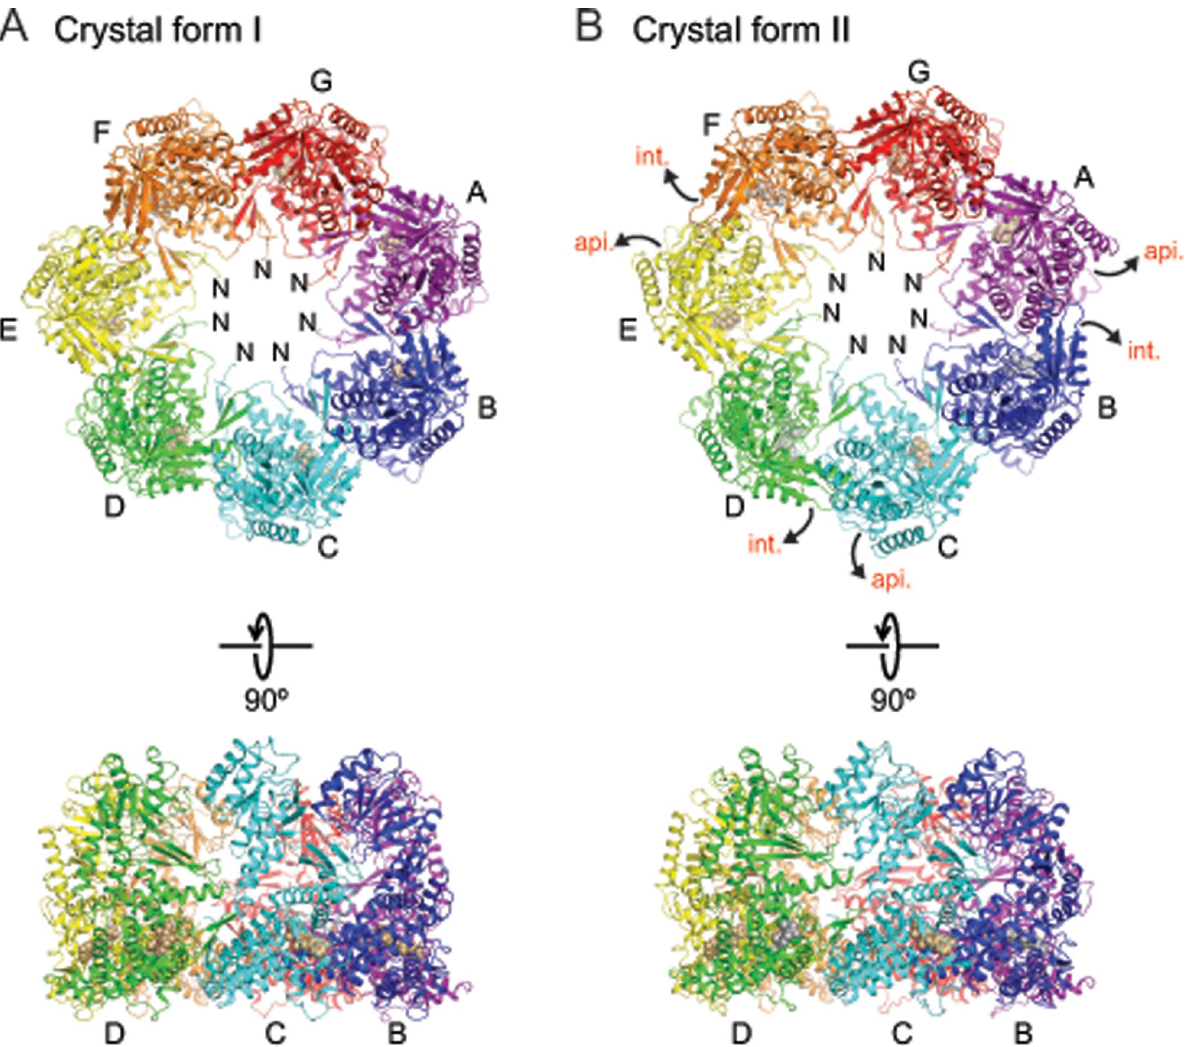
Fig 5. Crystal structures of ɸ EL. (A) Ribbon representation of the ɸ EL complex in crystal form I. Perpendicular views of the ɸ EL complex are shown. The subunits are shown in rainbow colors. Bound ATP and Mg 2+ is colored beige and shown in space-filling mode. Subunit chain identifiers and N-termini are indicated. (B) Structure of the ɸ EL complex in crystal form II, using the same representation style. Bound ADP is colored silver and shown in space-filling mode. Domain movements in ɸ EL subunits compared to crystal form I are indicated by curved